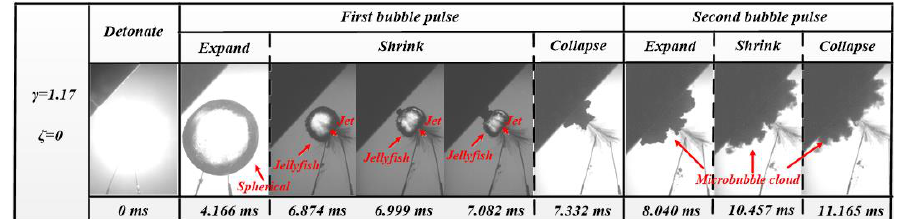
Figure 11. Type III bubble pulsation process diagram. The bubble pulsation process when ζ = 0 and γ = 1.17.